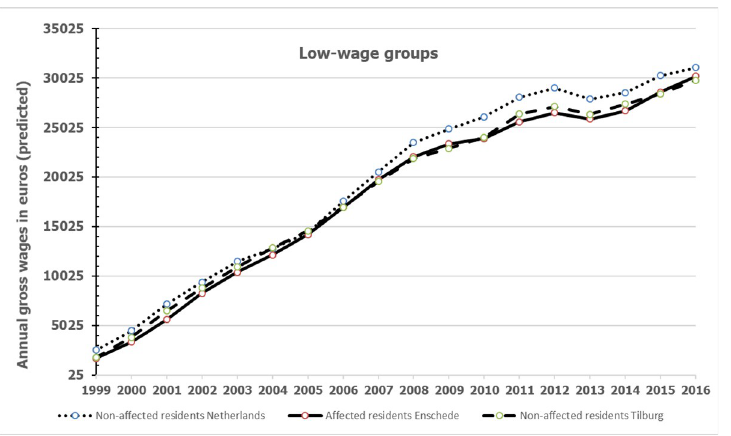
Fig 2. Gross annual mean wage of the low-wage group of affected residents and the non-affected control groups.